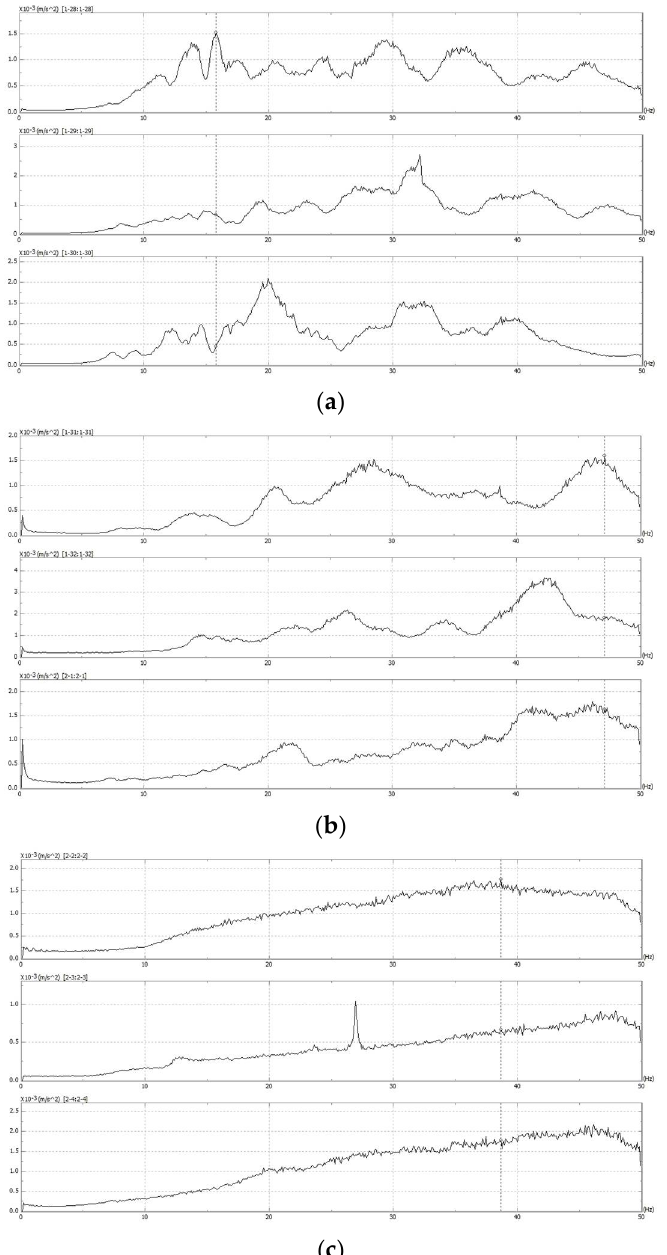
Figure 8. Frequency spectrums of sampling hole Z-4. ( a ) Measuring point 01; ( b ) Measuring point 02; ( c ) Measuring point 03.